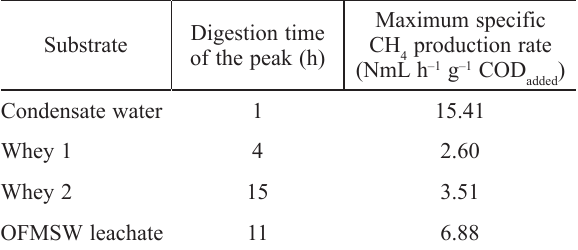
Table 2 – Maximum specific methane production rate (ex- pressed as NmL CH